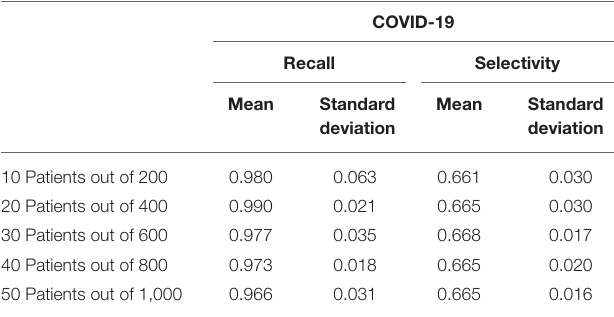
TABLE 1 | Recall and selectivity of linking fever as a first symptom of patients with COVID-19.